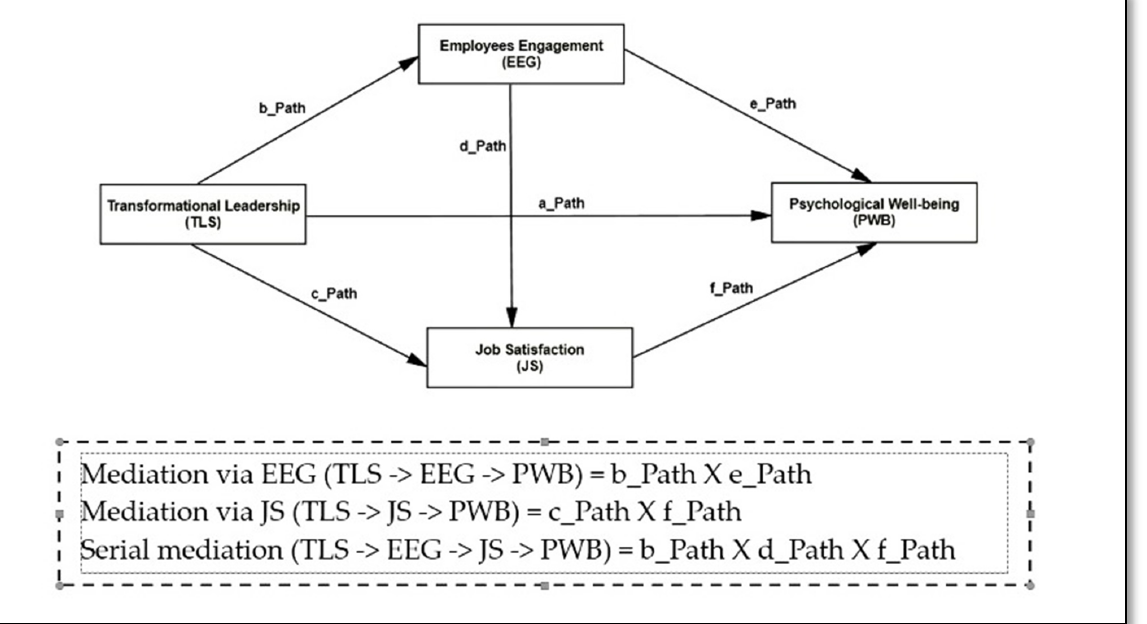
Figure 1. Study conceptual